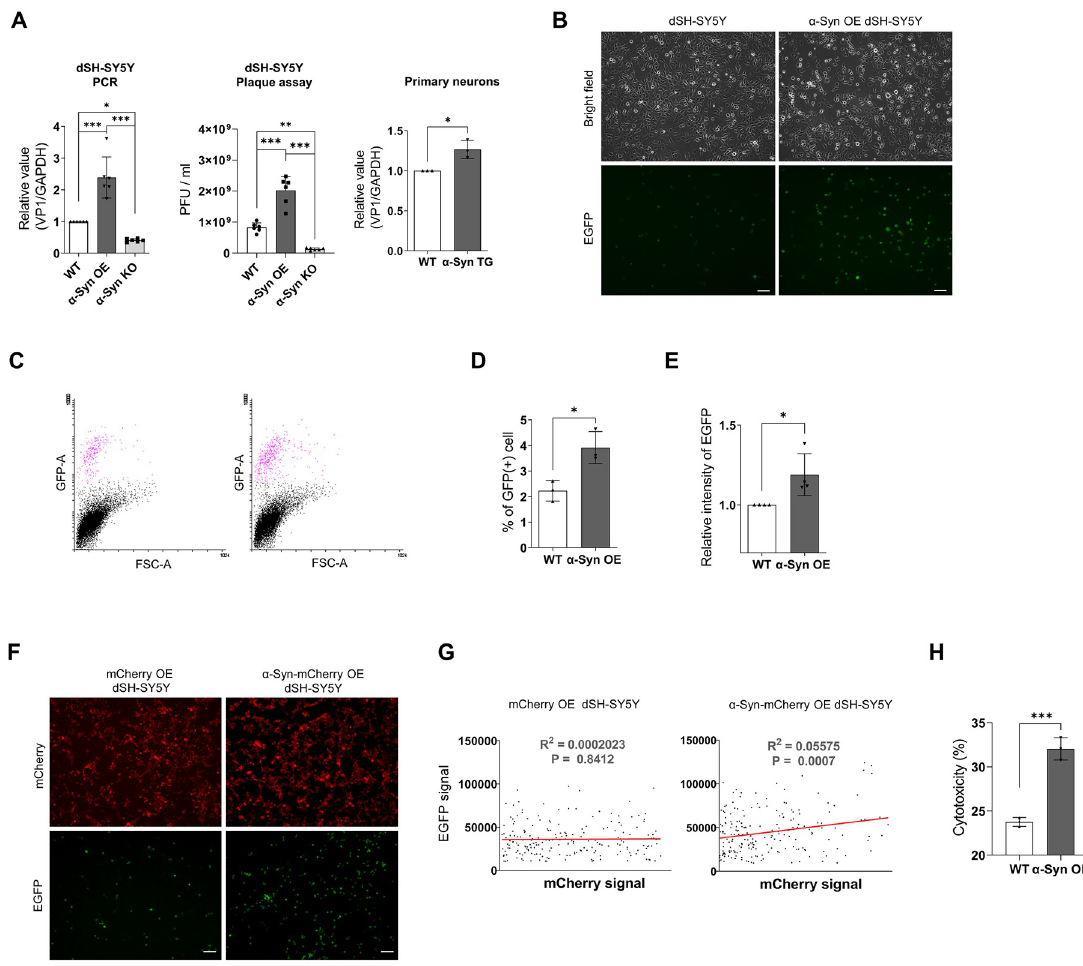
Fig 4. α -Syn regulates replication of CVB3 in neurons. (A) The relative levels of VP1 as analyzed by PCR and plaque assay between WT, α -syn OE, and α -syn KO dSH-SY5Y cells that were infected with CVB3 (MOI 0.25) for 24 h. In case of plaque assay, each cell was infected with CVB3 (MOI 1) for 30 h. The relative levels of VP1—as analyzed by PCR—between WT and α -syn TG mice primary cortical neurons that were infected with CVB3 (MOI 5) for 24 h. Values are derived from six or three independent experiments (n = 6 or 3). ��� P < 0.001, �� P < 0.01, � P < 0.05, one-way ANOVA test with Tukey’s multiple comparison test and unpaired t-test. (B) Fluorescence microscopy images of WT and α -syn OE dSH-SY5Y cells that were infected with 0.6 MOI CVB3 variant co-expressing EGFP (CVB3-EGFP) for 24 h. Scale bar indicates 50 μ m. (C, D and E) Flow cytometric analysis. The number of EGFP-positive cells (D) and intensity (E) were analyzed using WT and α -syn OE dSH-SY5Y cells that were infected with CVB3-EGFP (MOI 0.6) for 24 h. Values are derived from three or four independent experiments (n = 3 or 4). � P < 0.05, unpaired t-test. (F) Fluorescence microscopy images of mCherry and α -syn-mCherry OE dSH-SY5Y cells infected with CVB3-EGFP (MOI 0.6) for 24 h. Values and values are derived from three independent experiments (n = 3). Scale bar indicates 50 μ m. (G) Linear regression analysis of mCherry and EGFP intensity of mCherry and α -syn-mCherry OE dSH-SY5Y cells infected with CVB3-EGFP (MOI 0.6) for 24 h. Values are representative of three independent experiments. (H) Cytotoxicity analysis of WT and α -syn OE dSH-SY5Y cells infected with CVB3 (MOI 0.25) for 30 h by lactate dehydrogenase assay. Values are derived from three independent experiments (n = 3). ��� P < 0.001, unpaired t-test. (Figs 6D and S4B). The number of CVB3-infected microglia increased at day 7 PI (Figs 6E and S4C). At day 28 PI, the number of CVB3-infected microglia was similar to that at day 7 PI (Figs 6E and S4C). The number of CVB3-infected microglia was also higher in TG mice than in WT mice during the same period (Figs 6E and S4C). In addition, activation of microglia was observed upon CVB3 infection (S5 Fig).